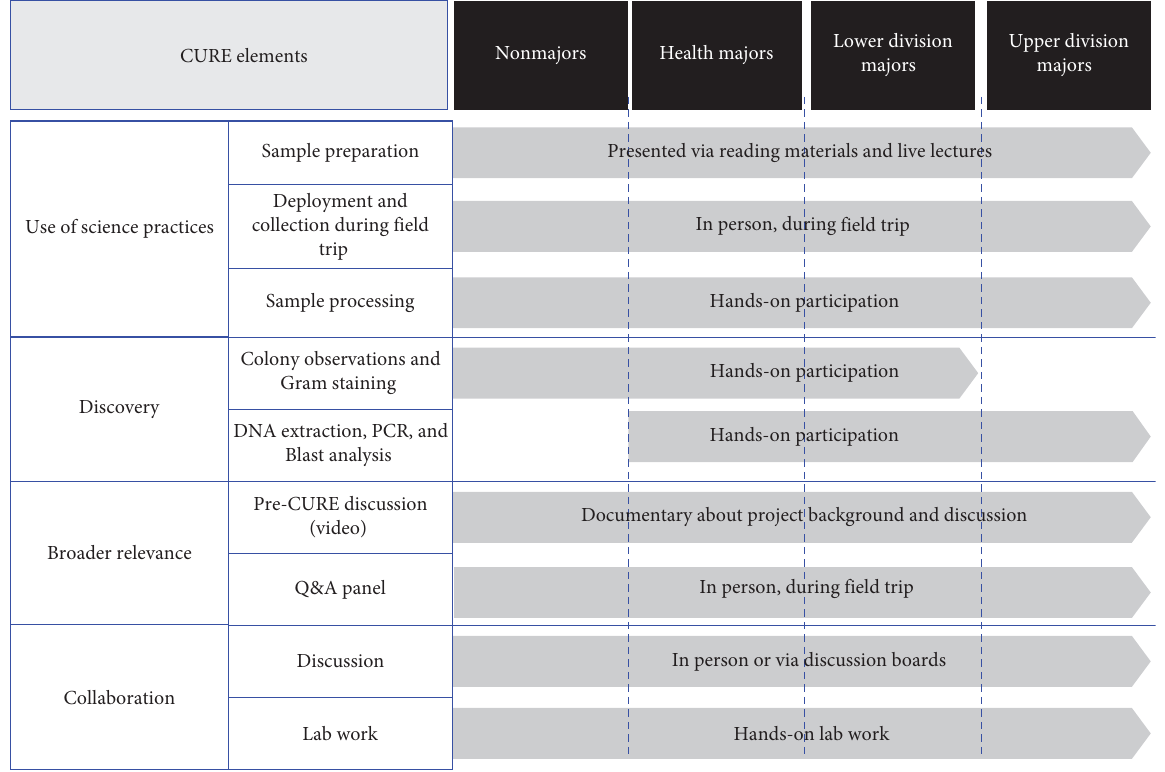
F IGURE 1: Overview of the activities included as part of the CURE. The fi gure refers to the original design, which was planned as mostly in-person activities. Created with BioRender